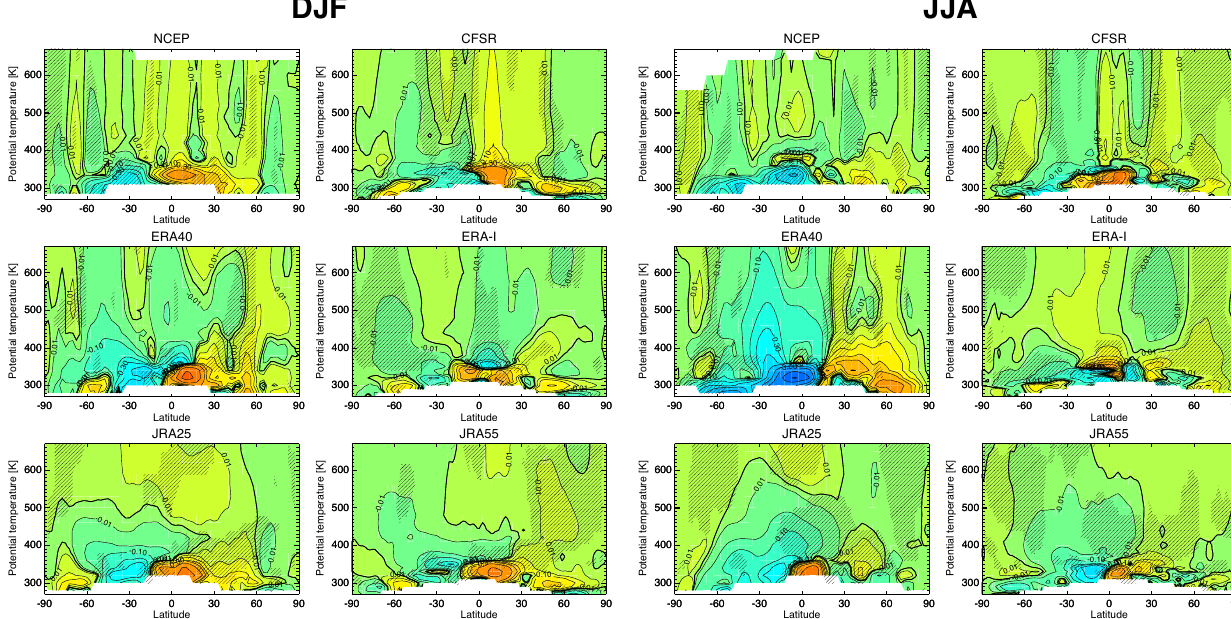
Figure 5. Same as in Fig. 3 but for the linear trend slope (10 10 kgs − 1 decade − 1 ). Statistically significant trends at the 95% level are indicated by hatching.